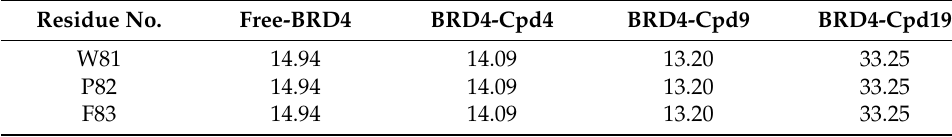
Table 2. The probability of the α -helix in the four systems.